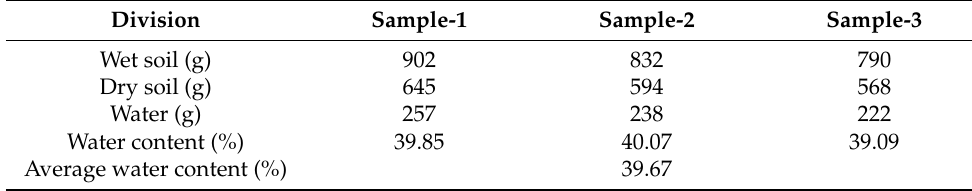
Table 2. Water-content test results for the stone sludge.